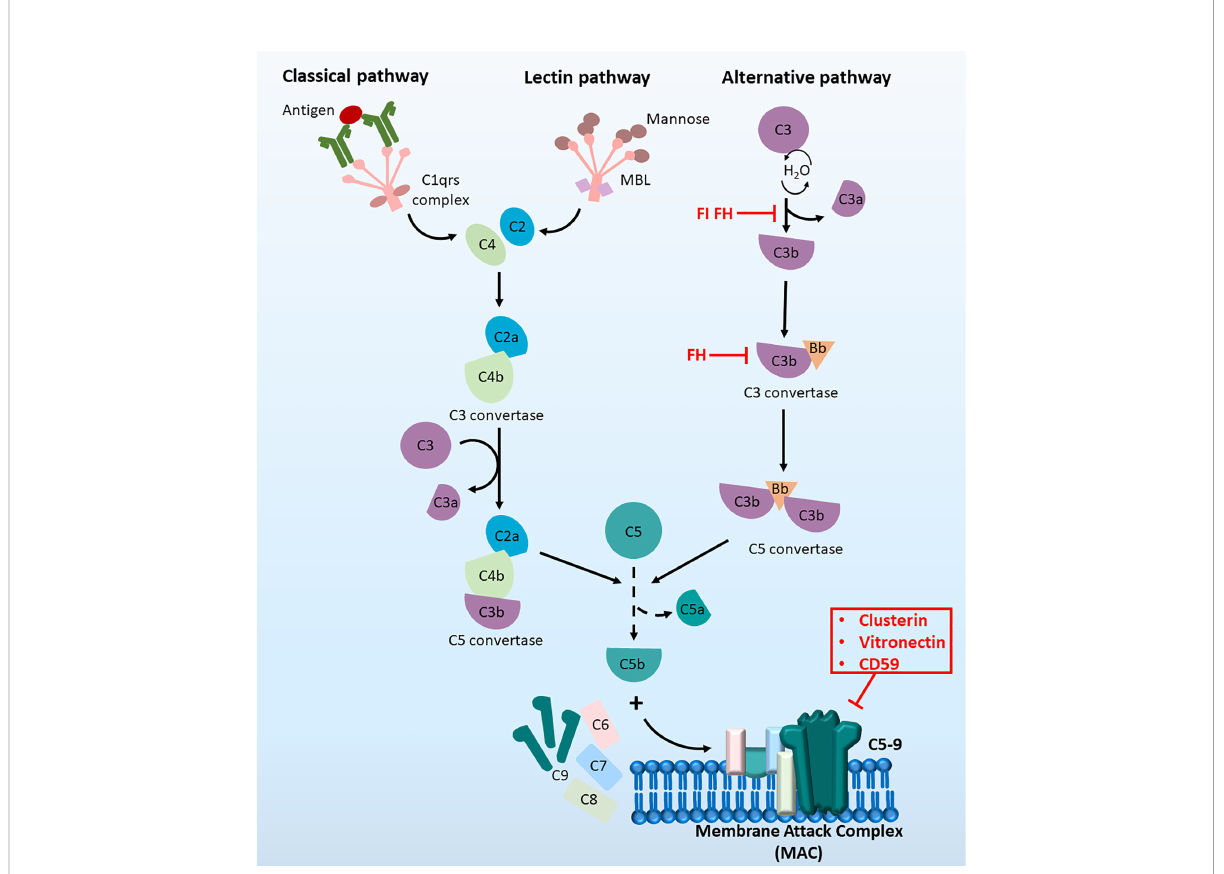
FIGURE 1 The complement cascade at a glance. The complement cascade can be activated by three pathways, (1) The classical pathway, (2) the lectin pathway and (3) the alternative pathway. Initiation of all three pathways can lead to the formation of C5 convertase to produce C5b, which then recruit C6, C7, C8 and C9 molecules. Together these components can form the terminal membrane attack complex (MAC), which induce cell lysis by inserting pores in cell